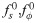
Mechanics of inversion: Elastic model and open questions.(a) Cell shape changes (labelled ‘CSCs’) endow an axisymmetric elastic shell with intrinsic meridional (s) and circumferential (ϕ) stretches fs0,fϕ0. Since these are, in general, incompatible with the global geometry of the shell, it deforms elastically to adopt stretches fs,fϕ. Analogously, the intrinsic curvatures κs0,κϕ0 of the shell differ from its actual curvatures κs,κϕ. Detailed mathematical derivations are provided in the Materials and methods section. (b) Inversion mechanics: our earlier work [43] revealed that active bending, contraction, and expansion are necessary for the early stages of inversion, but did not resolve the coupling of the waves of bending and expansion observed in [44]. (c) The peeling of the anterior hemisphere during the later stages of inversion is associated with another wave of cell shape changes [44], but the mechanical basis for the peeling has remained unclear. Cell shape changes A → B between cell types A,B are indicated in panels b,c, with the legend on the right of panel c recalling the definitions of cell types of Fig 2. Red lines in insets mark the position of cytoplasmic bridges. (d) Piecewise constant or linear functional form of the intrinsic stretches fs0,fϕ0, plotted against the arclength s of the undeformed shell. (e) Functional form of the meridional intrinsic curvature κs0. (f) Functional form of the circumferential intrinsic curvature κϕ0. Labels in panels d, e, and f define the 15 parameters f1,…,f5, κ1,…,κ5, s1 <…< s5 discussed in the text. The values of these parameters depend on the inversion stage and are obtained numerically by a fitting algorithm comparing experimental and numerical embryo shapes.